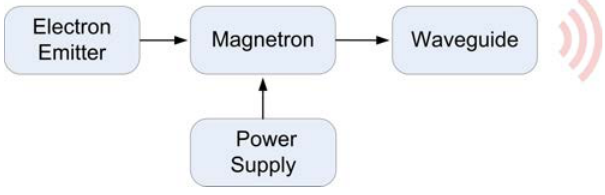
Fig. 1. Schematic diagram of magnetron modulation